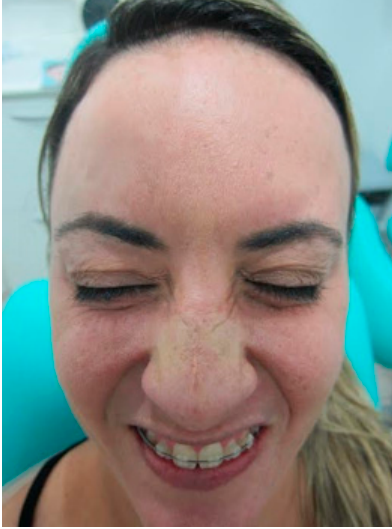
Figure 6. After 14 days, contraction of the procerus and corrugator muscles shows an equilibrium.